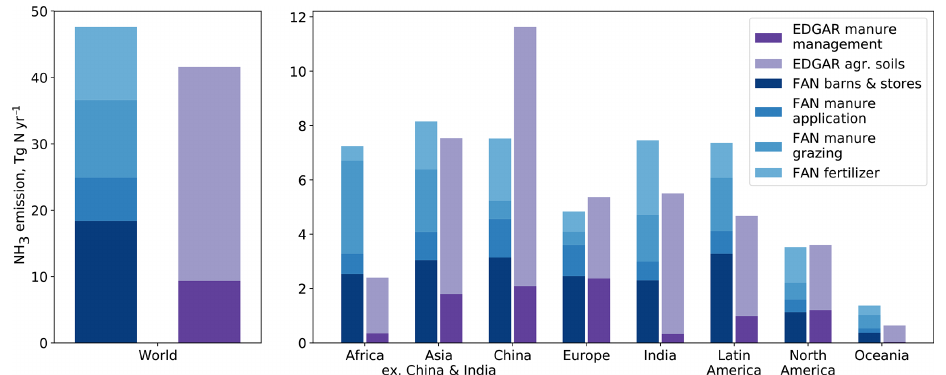
Figure 10. Global and regional ammonia emissions from agricultural sources in FANv2 (for the years 2010–2015) and EDGAR v4.3.2 (for 2010; Crippa et al., 2018; TgNyr − 1 ). The EDGAR manure management emissions correspond to barns and stores in FANv2. Table 2. Simulated NH 3 emissions by region averaged for the years 2010–2015 and compared with existing inventories. The total emission is equal to manure management + agricultural soils or total manure + synthetic fertilizer. For FANv2, manure management emissions are equal to the emissions from barns and